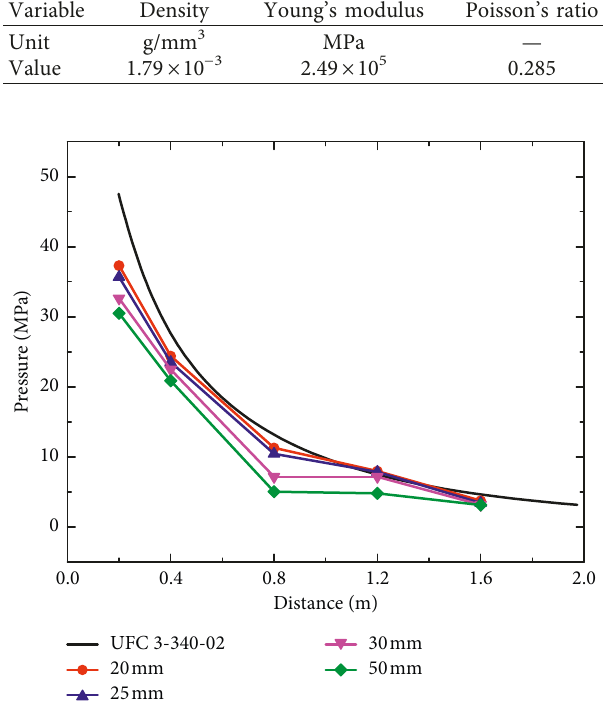
Figure 4: Comparison of different mesh sizes.